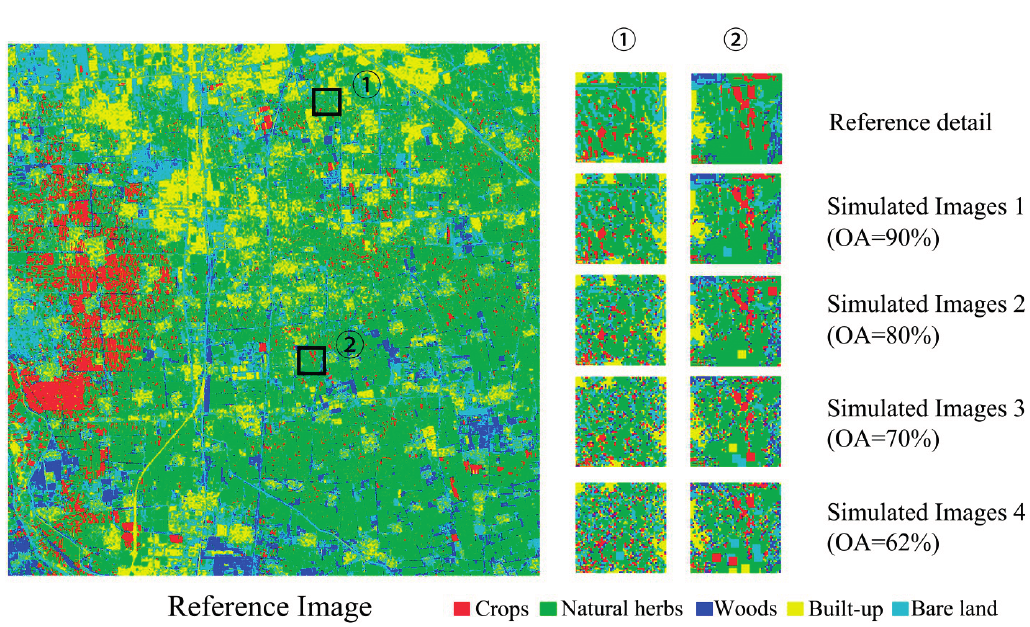
Figure 3. Simulated